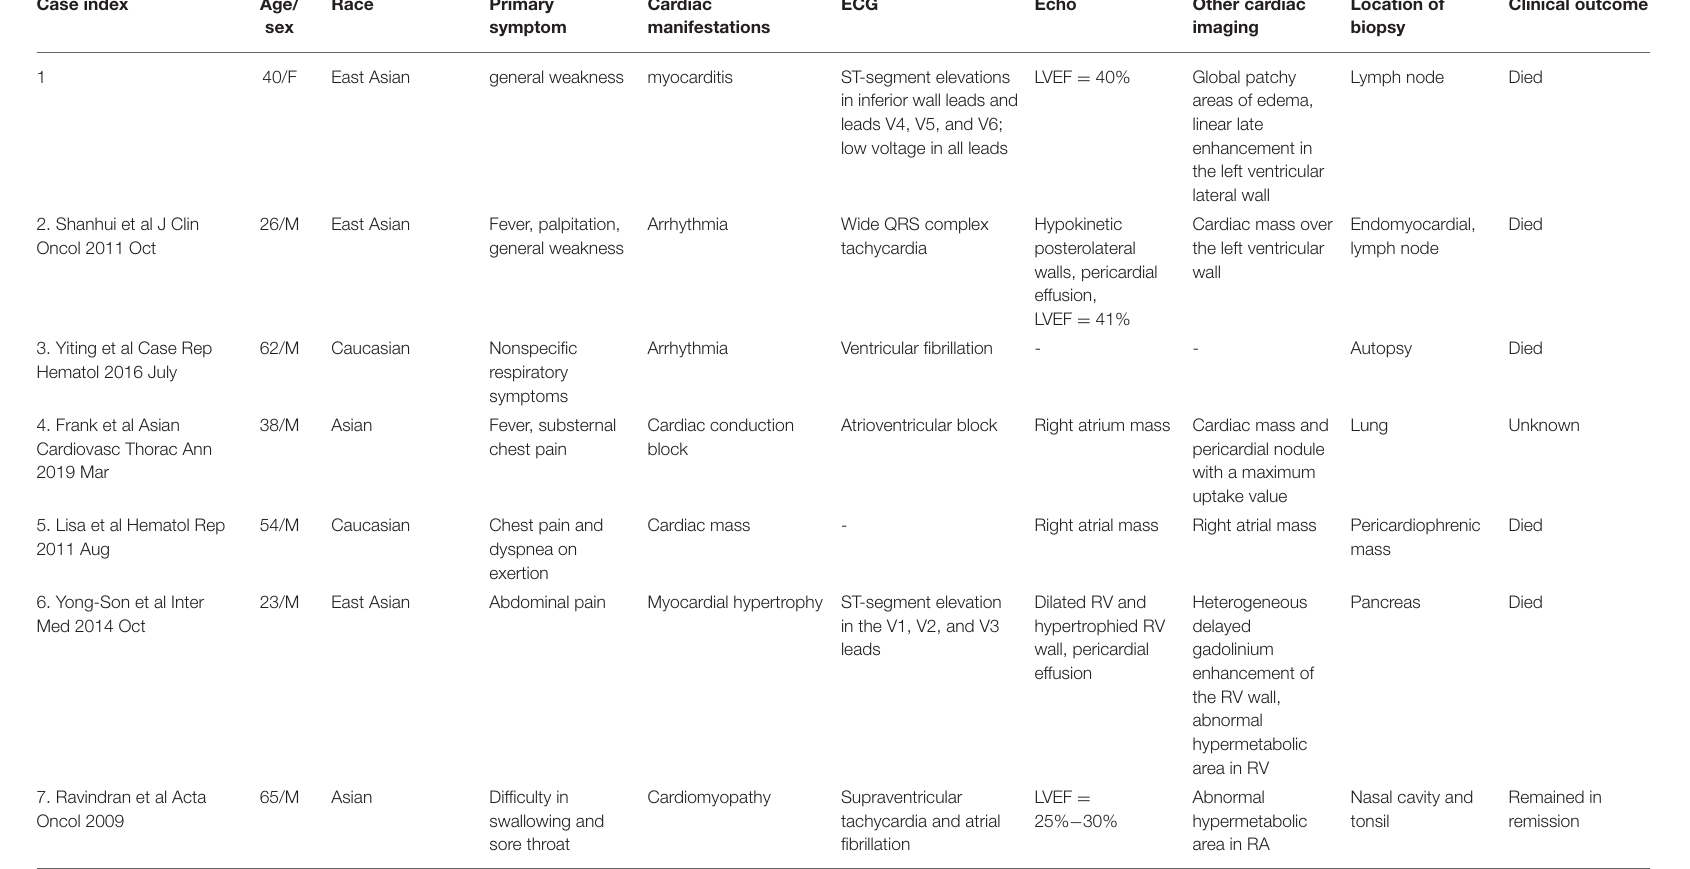
TABLE 2 | Summarization of reported NKTL patients and our